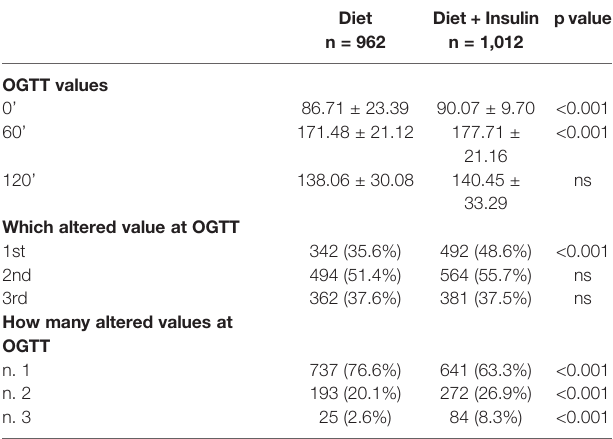
Values are expressed as mean ± SD or n(%). OGTT, oral glucose tolerance